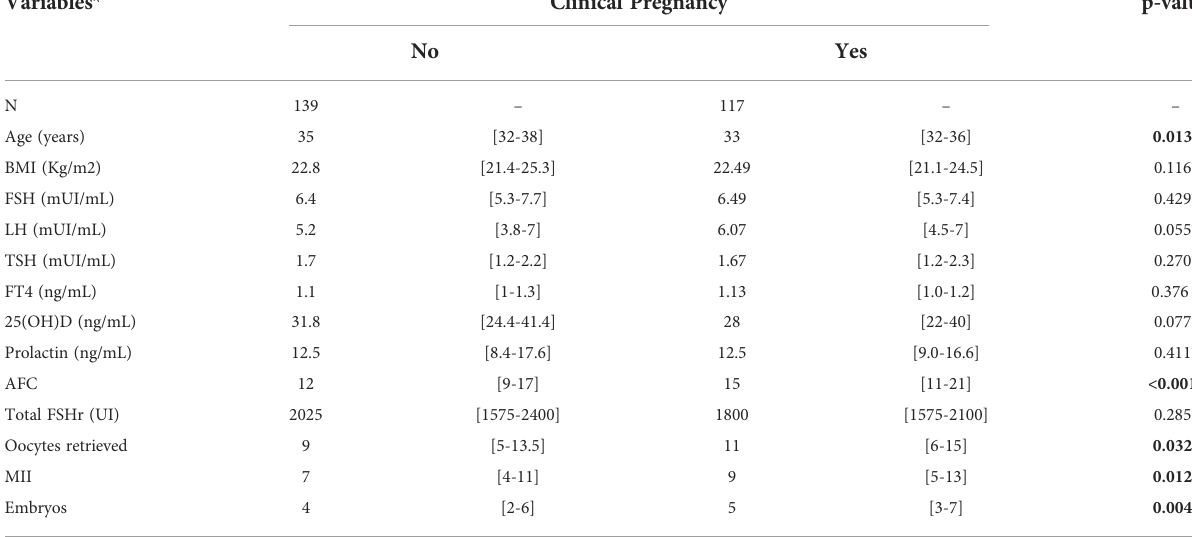
TABLE 2 Clinical characteristics, hormonal pro fi le and reproductive outcomes of infertile women according to clinical pregnancy outcome. Variables*